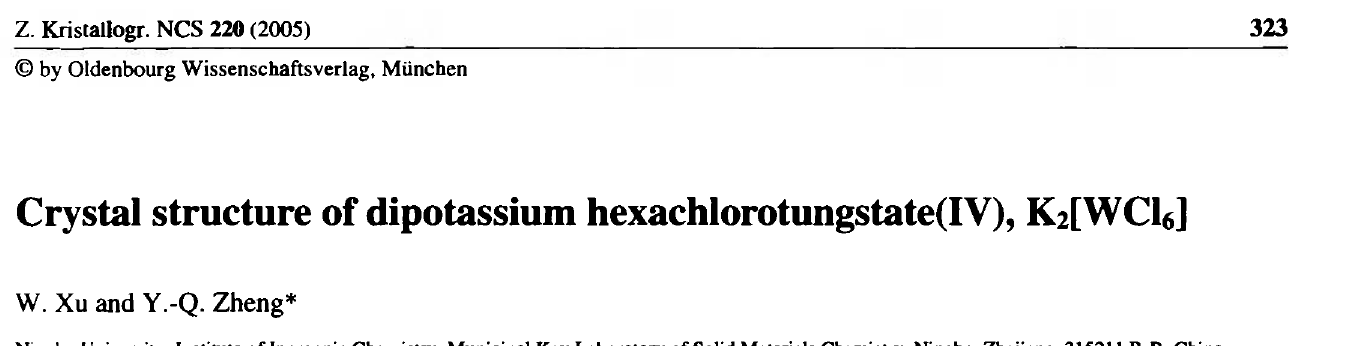
Table 1. Data collection and handling.